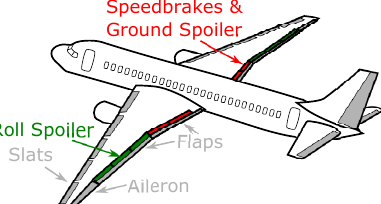
Figure 2. Primary (grey) and secondary (red, green) flight control surfaces on a commercial